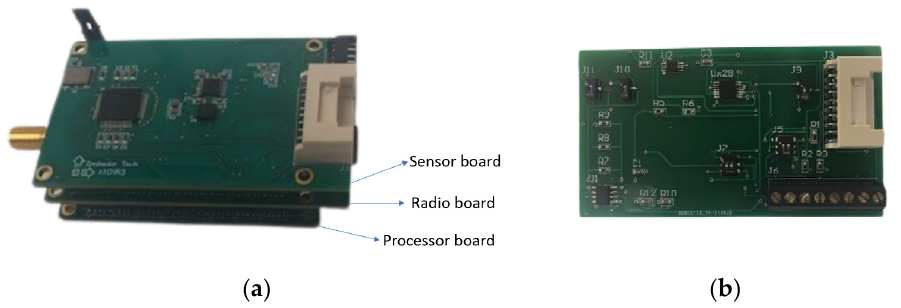
Figure 3. Xnode Smart Sensor. ( a ) Original Xnode platform. ( b ) Newly designed strain sensor extension.